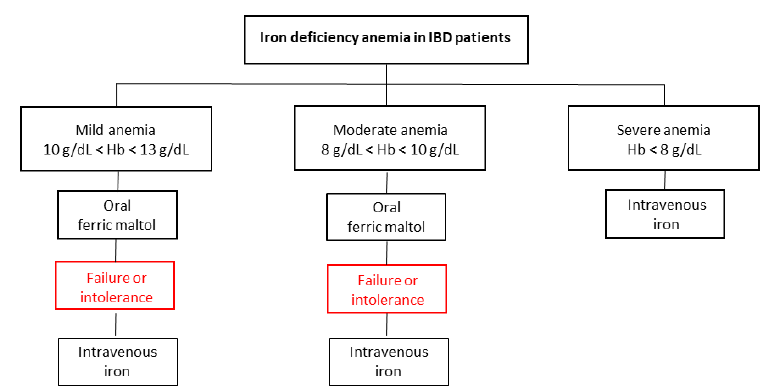
COVID-19 pandemic. COVID-19